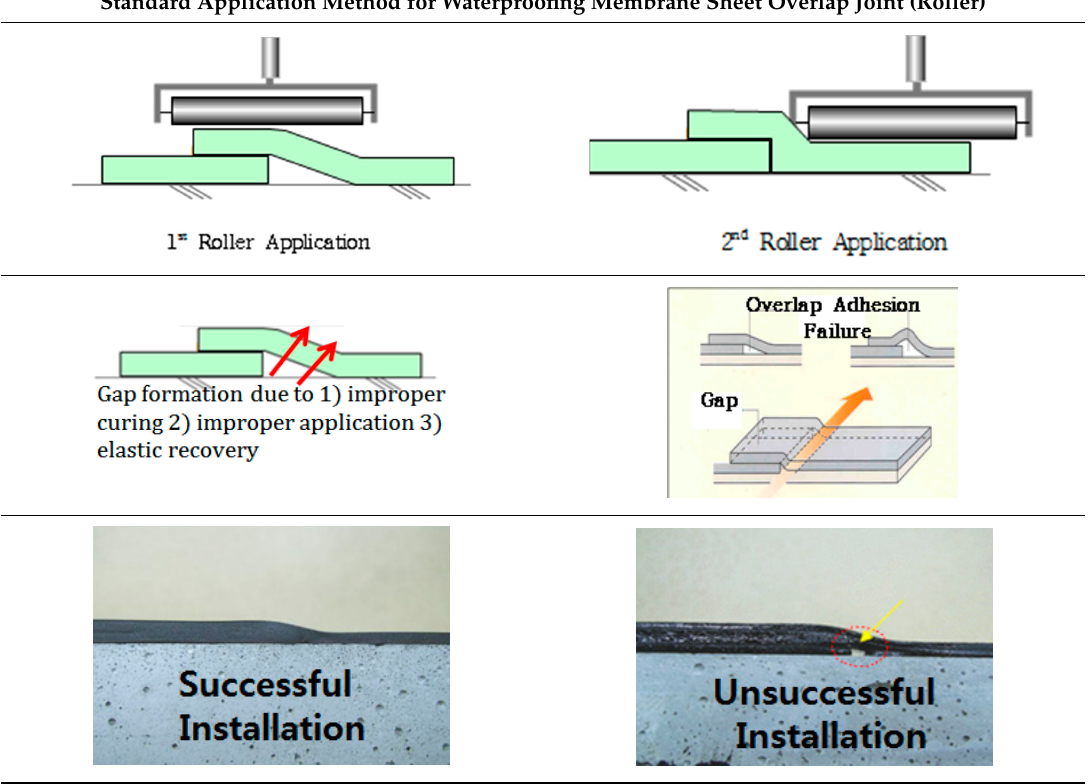
Table 6. International standards on required waterproofing membrane properties.